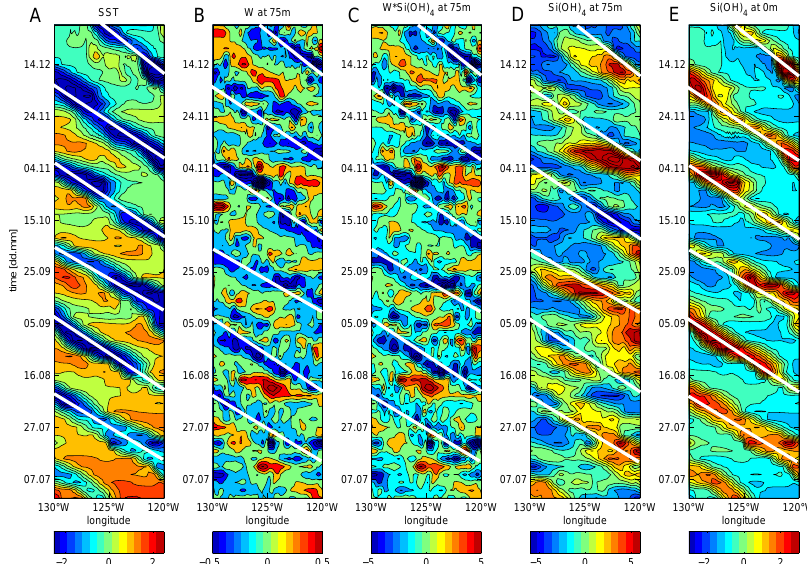
Fig. 8. Time–longitude diagrams of several key physical and chemical fields at 2 ◦ N. Period from June 2004 to December 2004 in days and months (dd.mm); longitude band from 120 ◦ W to 130 ◦ W. Panels from left to right show the unfiltered variability (mean removed) in: (A) SST ( ◦ C), (B) w at 75m (md − 1 ), (C) w · Si(OH) 4 at 75m (mmolSim − 2 d − 1 ), (D) Si(OH) 4 concentration at 75m (mmolSim − 3 ), and (E) surface Si(OH) 4 concentration (mmolSim − 3 ). White lines associated with approximate tracks of passing TIWs correspond to likely TIW tracks drawn along maximum negative SST variability in Fig.